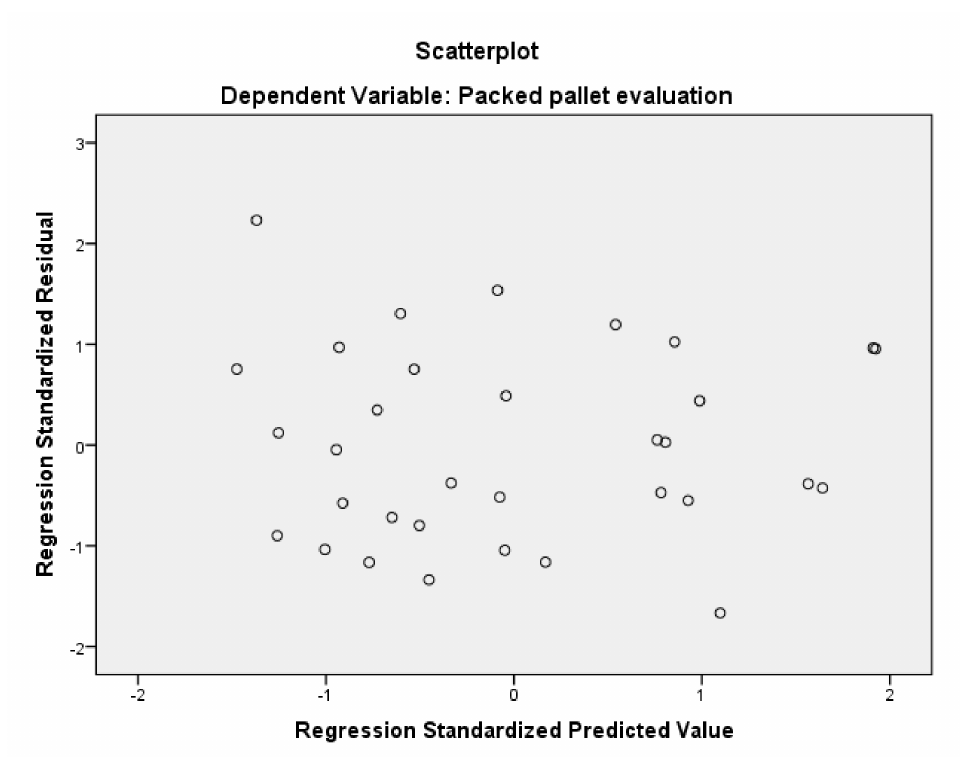
Figure 2. Scatterplot to test residuals homogeneity (for 2 principal